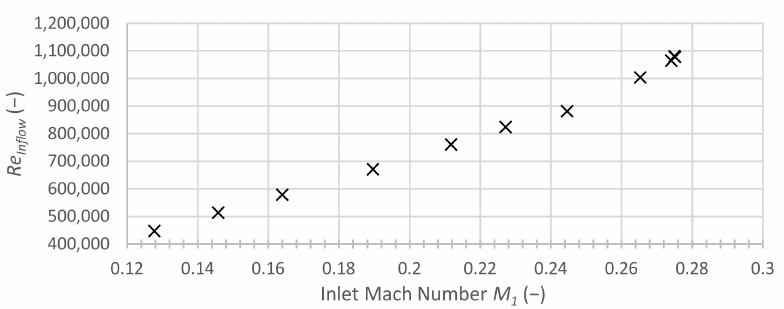
Figure 5. Inflow Reynolds number Re Inflow against inlet Mach number M 1 .